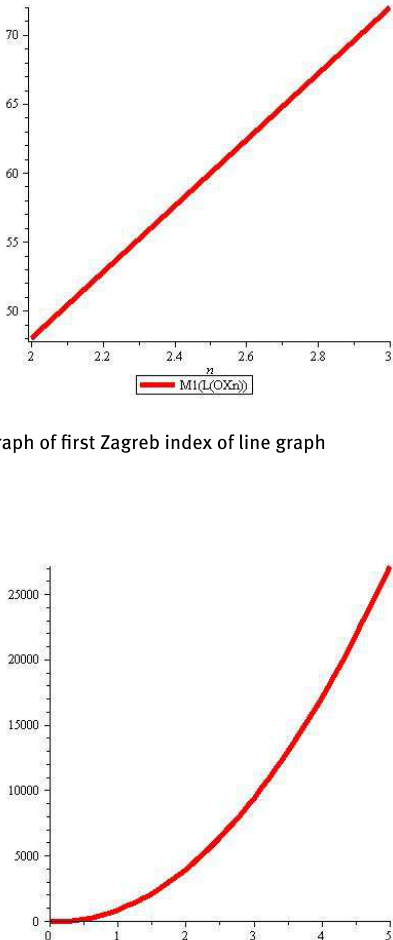
Figure 8: Graph of F ( OX n